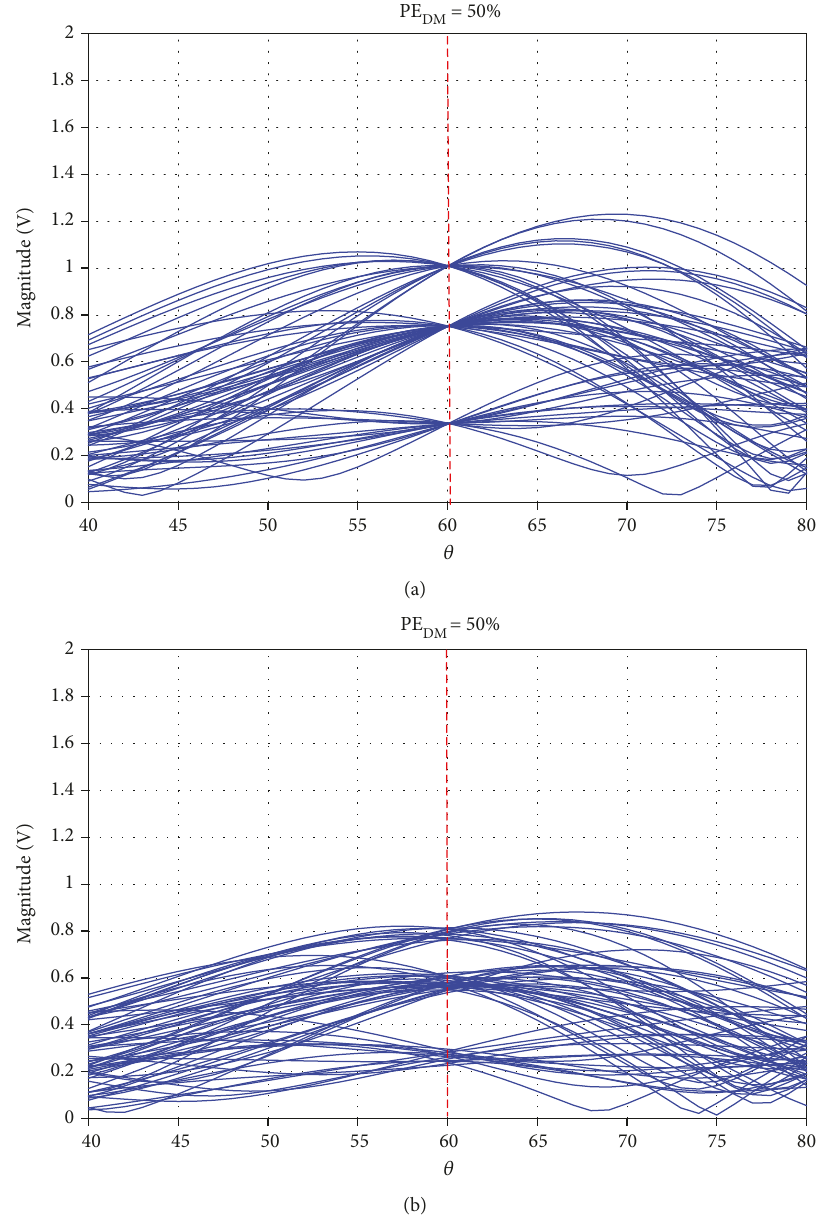
= 50% ) using (12) to compute S DM 21 mn in the